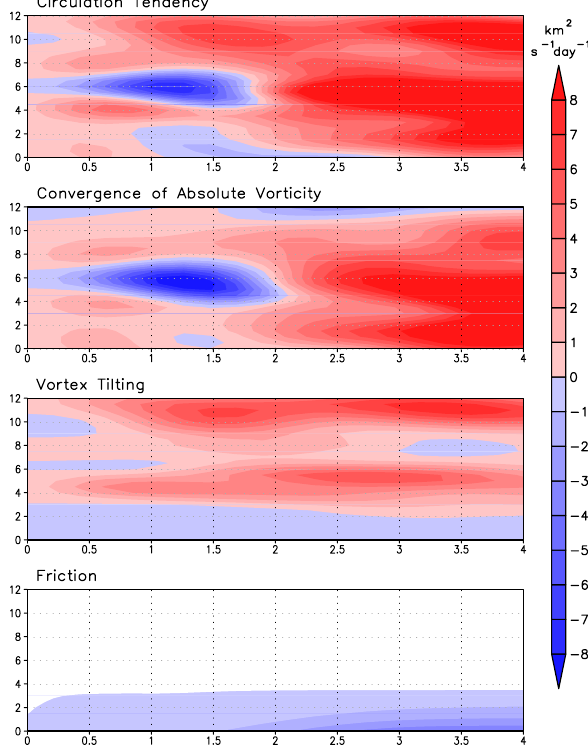
Figure 12. Four-panel height/distance cross-section of each term from the circulation tendency equation (Eq. 7) for Nuri 1. The abscissa is the length of the box (degrees) on which the integration is performed and is centered on the 1.5 km sweet spot position. The ordinate is height (km).